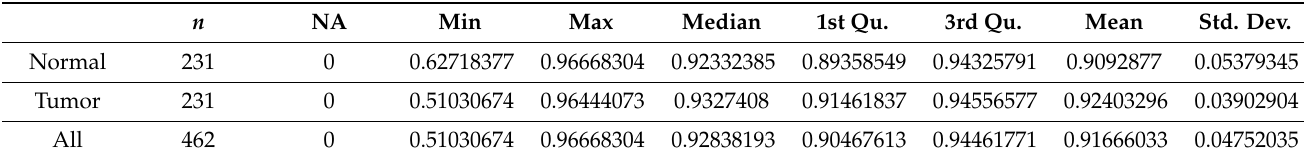
Table 7. Prostate β -values and